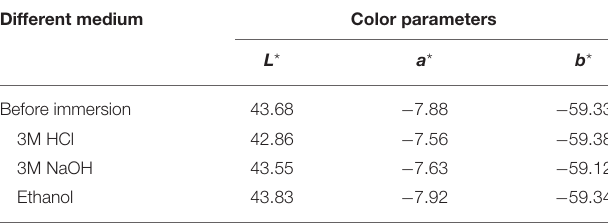
TABLE 2 | Color parameters of the sample plates before and after being immersed into 3M HCl, 3M NaOH, and ethanol for 72h, respectively. Different medium Color